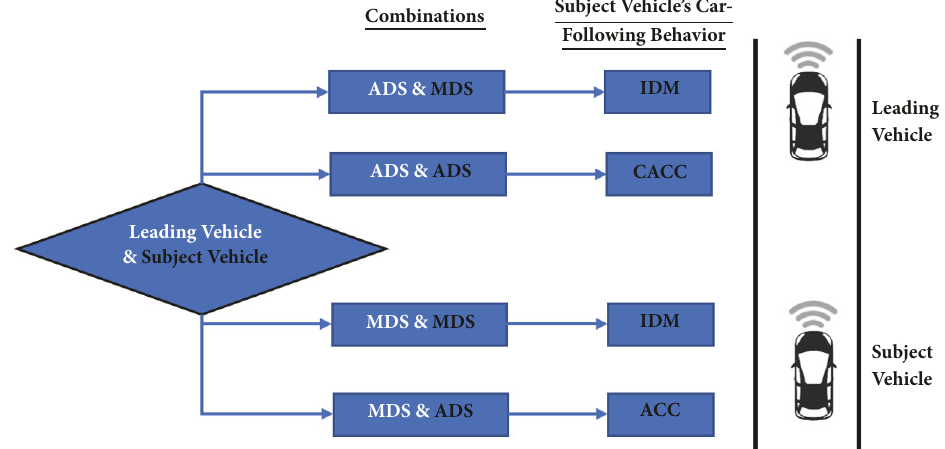
Figure 1: Proposed car-following strategy for mixed